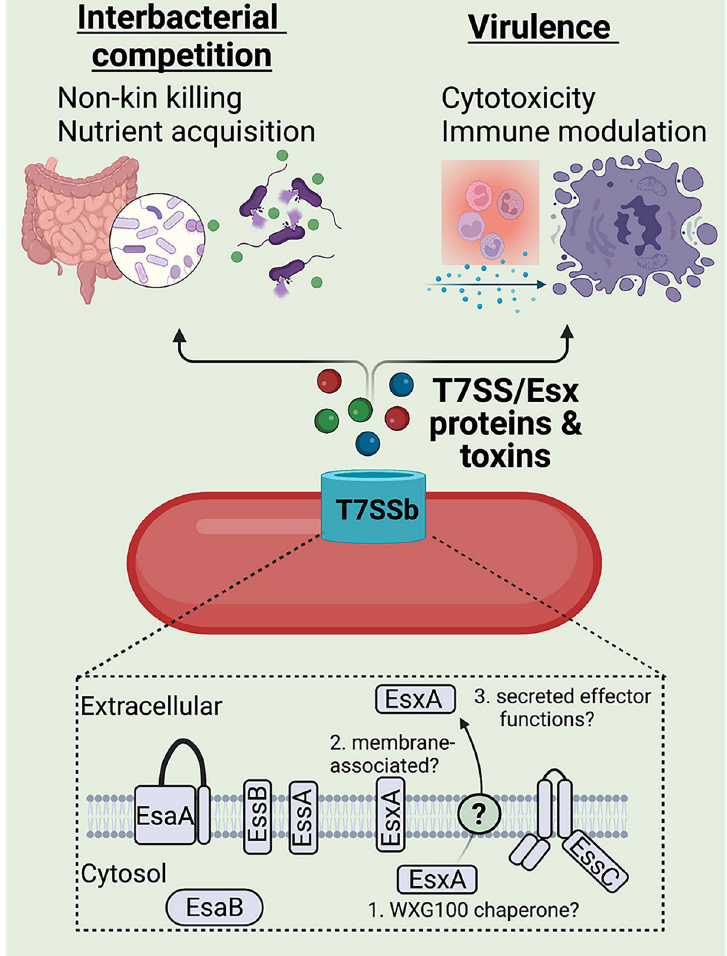
Fig 1. The T7SSb of Gram-positive bacteria encode primarily membrane-bound machinery including an EssC ATPase, which facilitates the export of small alpha-helical proteins and toxins. Structural depictions of T7SS machinery proteins as described in [2]. The putative functions of EsxA in T7SSb require further investigation but EsxA may putatively (1) chaperone other T7SS substrates; (2) associate with membrane T7SSb core components; and (3) exhibit cytotoxic and pore-forming activity as secreted effector. While T7SSb substrates are still being elucidated and characterized, the T7SSb as a whole has been shown in many species to play roles in interbacterial competition and